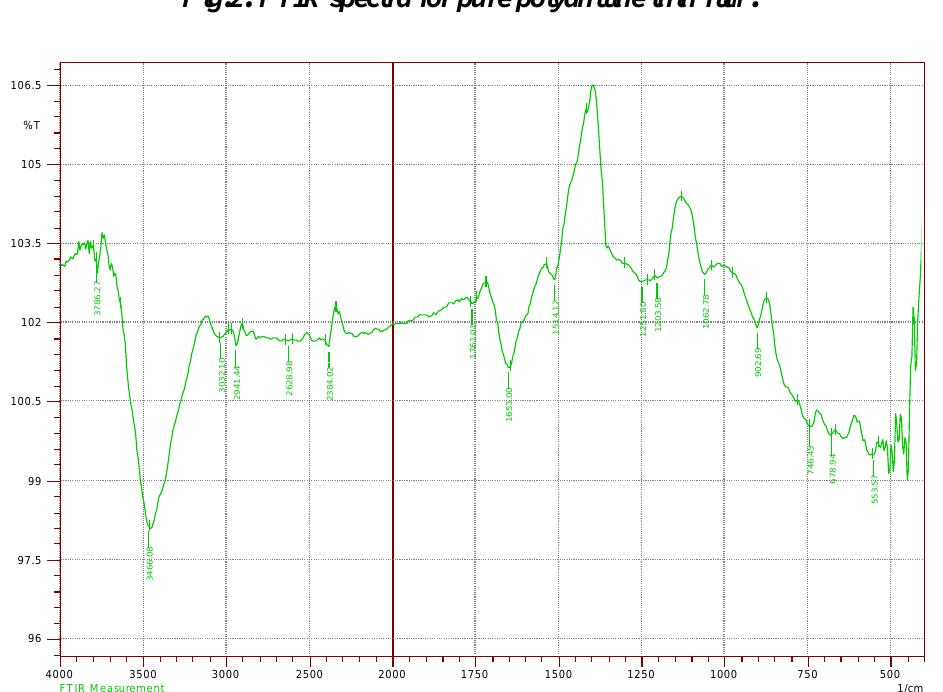
Fig.2: FTIR spectra for pure polyaniline thin film.